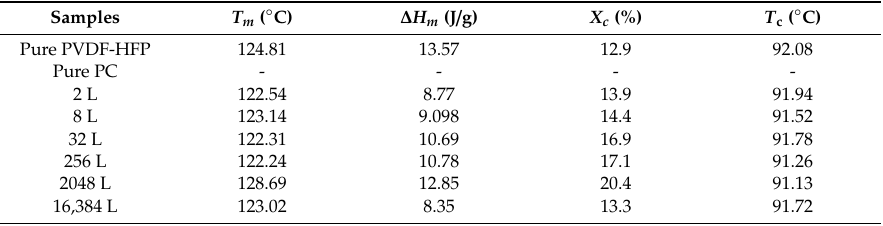
Figure 4. ( a ) WAXD profiles for coextruded PVDF-HFP/PC films varying the nominal number of layers. The intensity was normalized with film thicknesses. ( b ) FTIR spectra of PVDF-HFP/PC films. DSC thermographs of; ( c ) heating scan; and ( d ) cooling scan for coextruded PVDF-HFP/PC films. Table 2. Melting temperature ( T m ), enthalpy of fusion ( ∆ H m ), crystallinity ( X c ) and crystallization temperature ( T c ) obtained from the first heating scan of